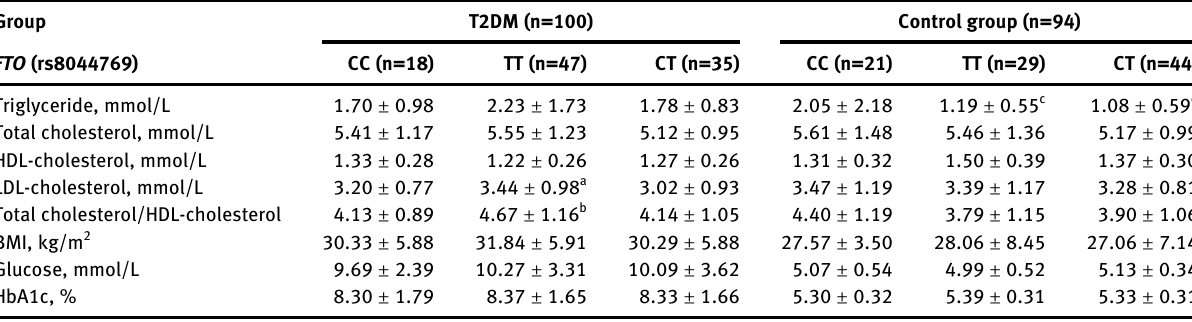
Table  : Distribution of FTO (rs  ) genotypes according to biochemical pro fi les in type  diabetes mellitus patient and control groups. Group